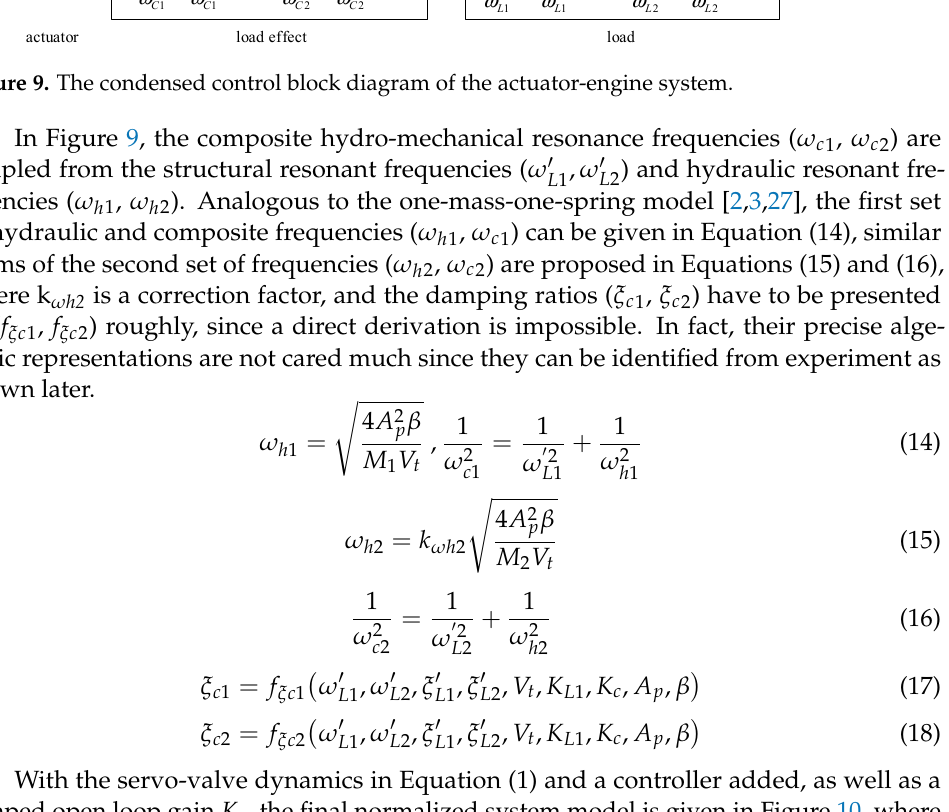
With the servo-valve dynamics in Equation (1) and a controller added, as well as a lumped open loop gain K o , the final normalized system model is given in Figure 10, where e ( t ) is the normalized position error between X c and X p .